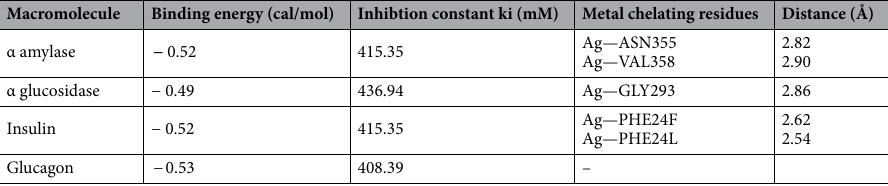
Table 2. Molecular docking analysis of silver